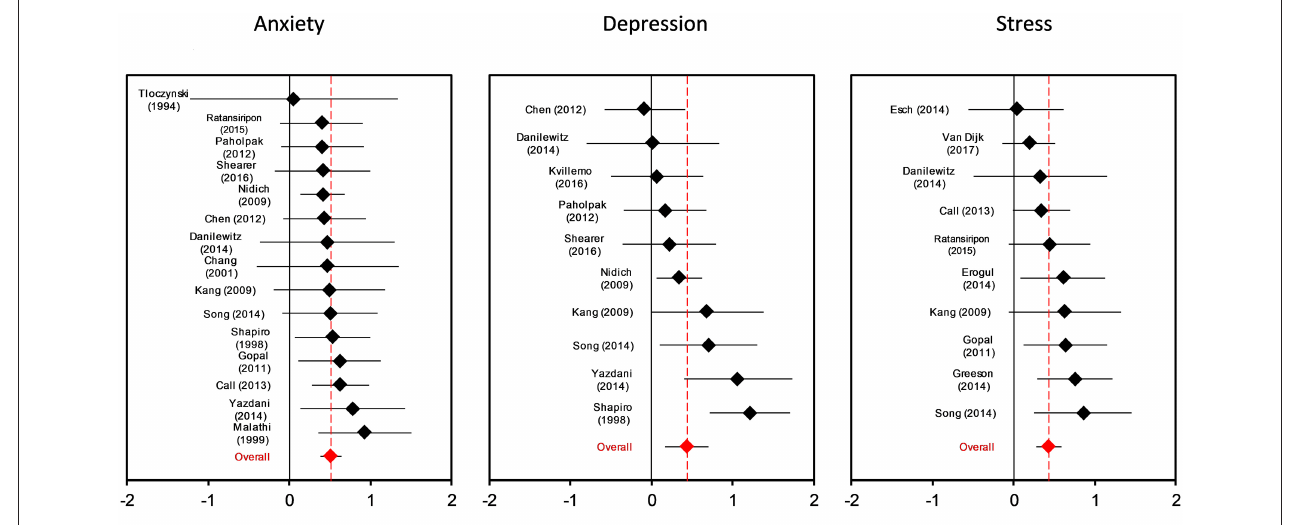
FIGURE 2 | Forest plot for intervention effects on anxiety, depressing and stress symptoms with Hedges